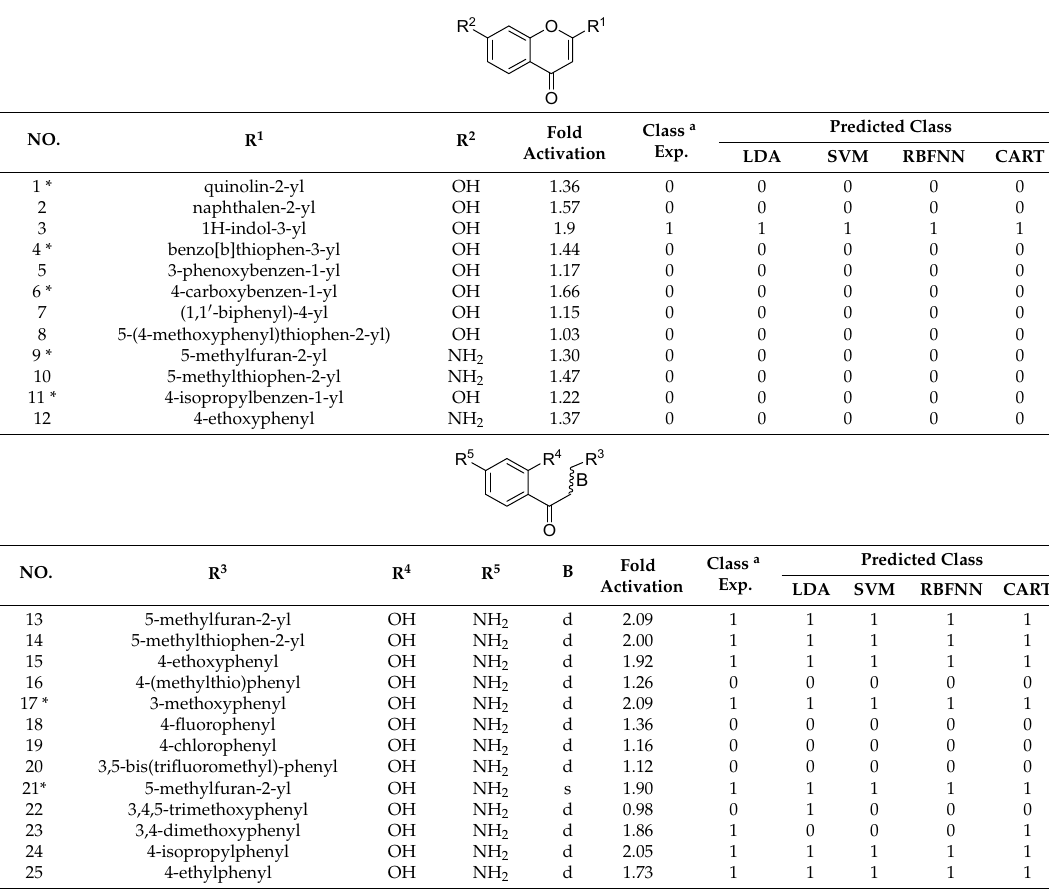
Table 2. The correlation matrix of descriptors. Table 3. Structures and classifications of flavonoids-based ABCA1 up-regulators in QSAR modeling.